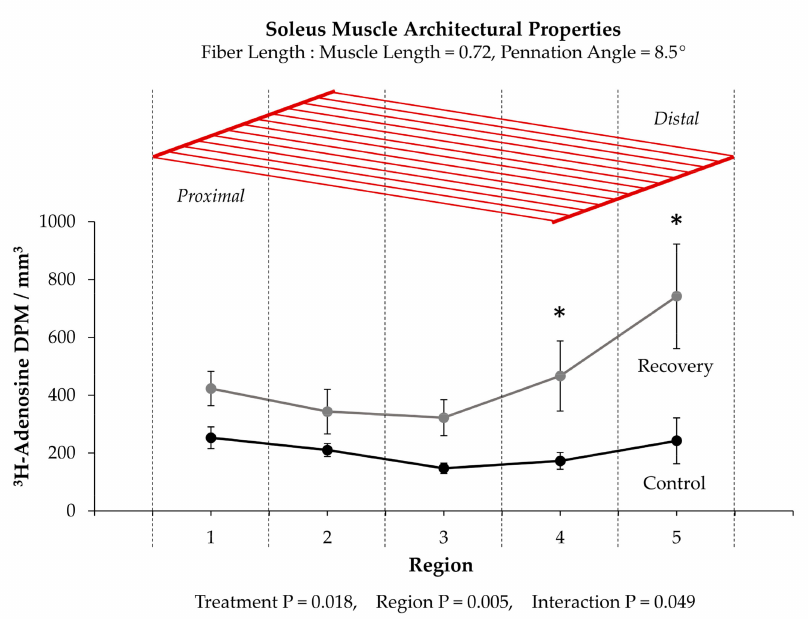
Figure 5. (Top) Schematic illustration of the soleus muscle and its basic architectural properties [142]. (Bottom) Summary of the data provided by Williams and Goldspink (1973) [135]. Values are presented as the means ± SEM and were analyzed with 2-way repeated measures ANOVA. p -values for the main e ff ects (i.e., Treatment and Region) and interaction are provided. * Significantly di ff erent from the region-matched control